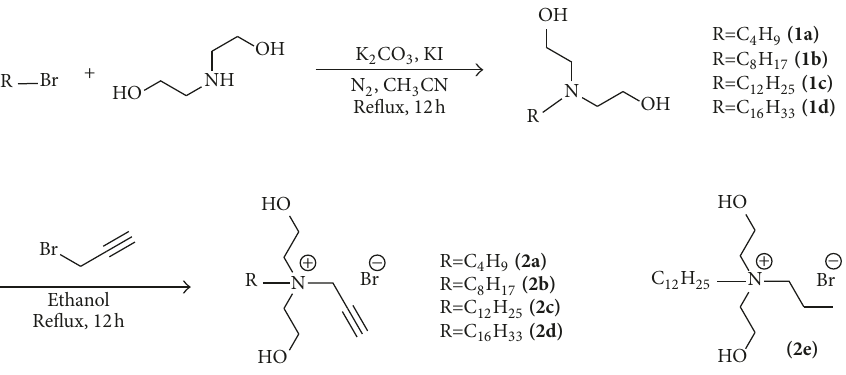
Scheme 1: Synthesis of propargyl quaternary ammonium surfactants 2a – 2d